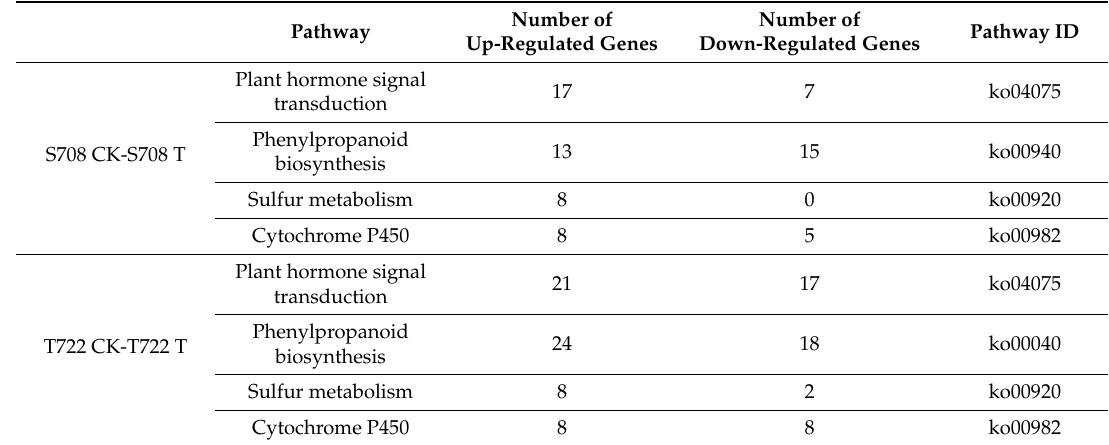
Table 3. Significantly enriched KEGG pathway of di ff erentially expressed genes (DEGs) in response to sub-optimal temperature (T, 15 / 10 ◦ C).